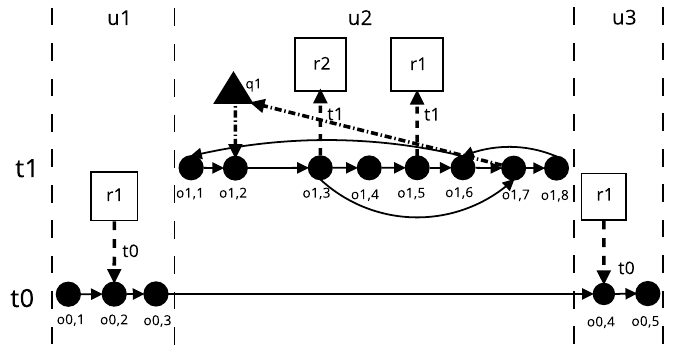
Figure 6. DL3 application operation